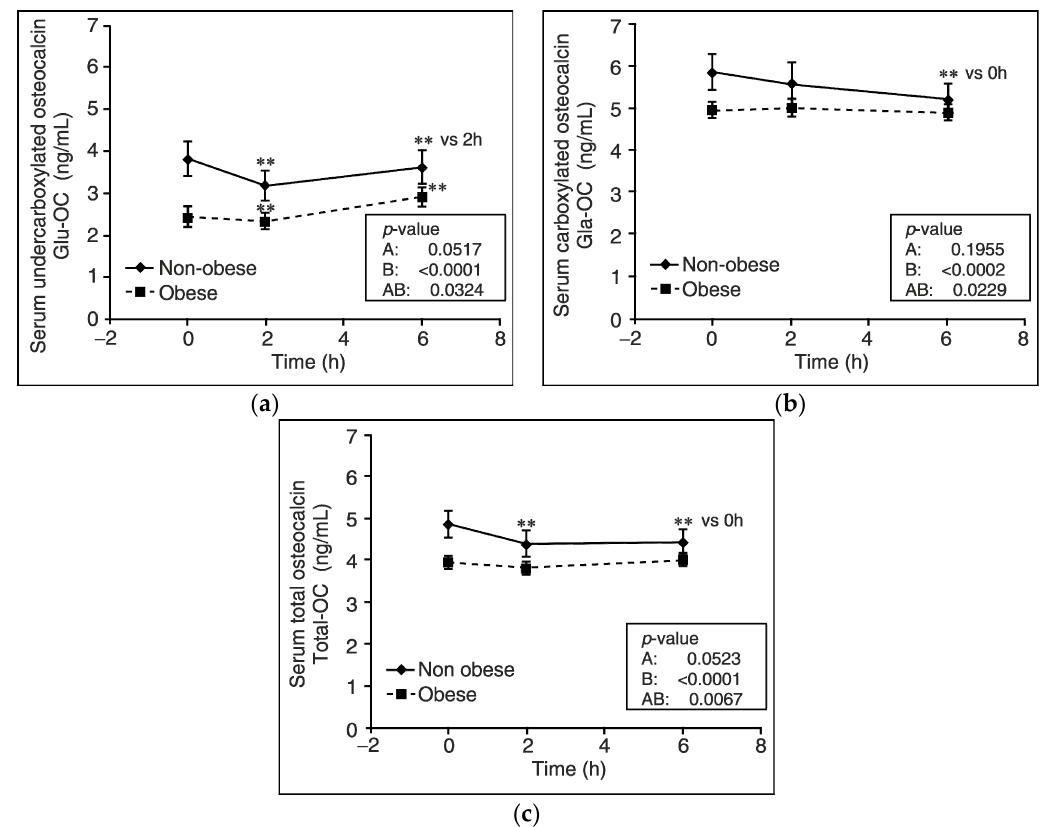
Figure 2. Changes in blood levels of osteocalcins during a high fat mixed meal tolerance test in obese ( n = 70) and non-obese subjects ( n = 24). ( a ) Undercarboxylated osteocalcin (Glu-OC) concentration in serum. ( b ) Carboxylated osteocalcin (Gla-OC) concentration in serum. ( c ) Total osteocalcin (total-OC) concentration in serum. Values are presented as means ± SEM. Statistics: Analyses were performed with repeated-measures by ANOVA and denote differences between non-obese and obese participants (A), differences over time (B), and differences owing to an interaction between group and time (AB). Values at single time points were compared by the Tukey post hoc test. Significant differences are indicated as follows: ** p < 0.01.